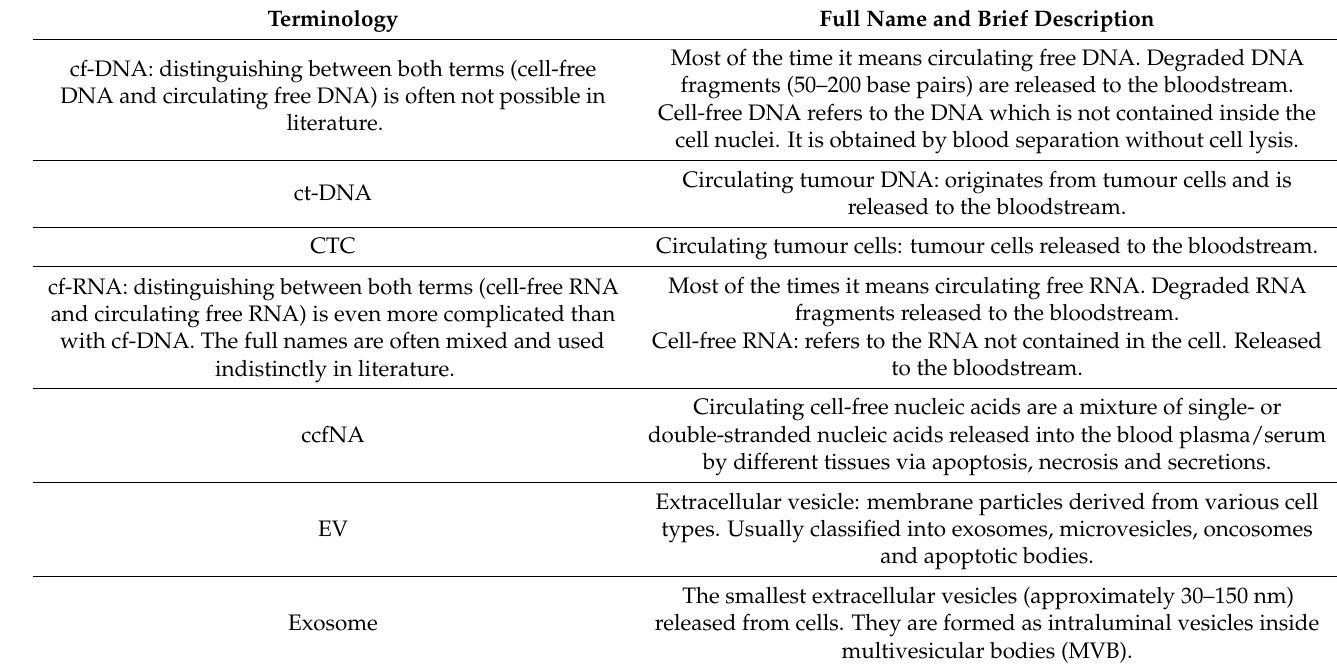
Table 1. Sources of liquid biopsy biomarkers and their